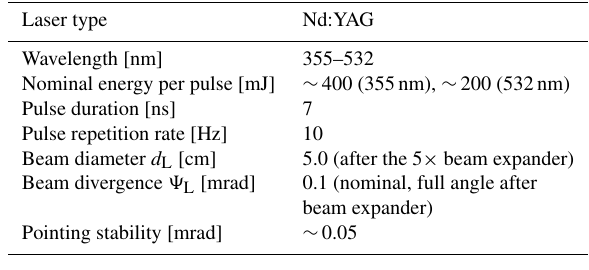
Table 1. Transmitter characteristics of the RMR lidar system.